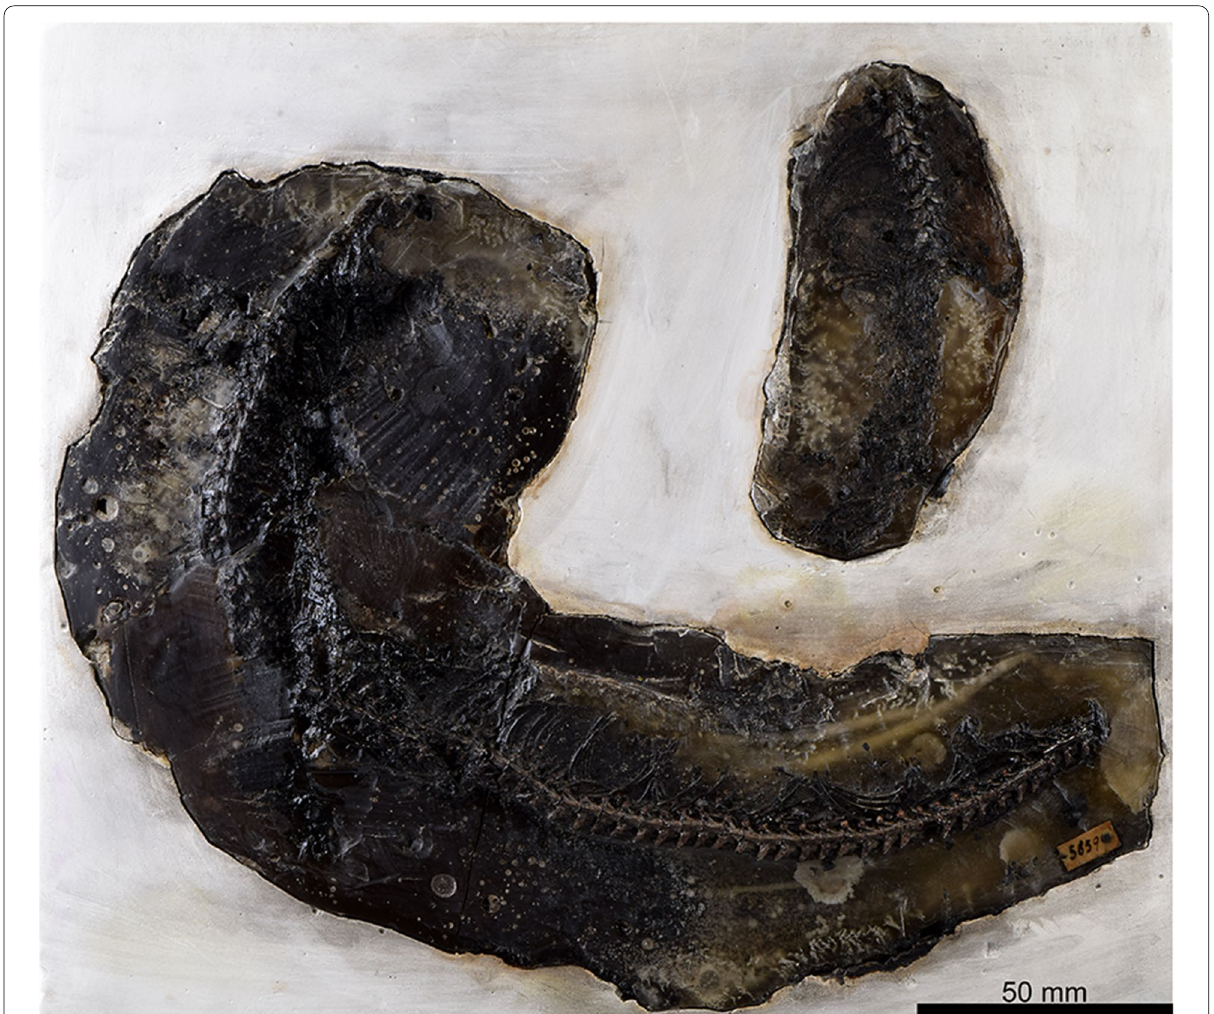
Fig. 107 Constrictores indet. from quarry Cecilie II, Geiseltal: several articulated trunk vertebrae on a matrix (GMH Ce II-5859-1930). Specimen originally figured by Kuhn (1939a:pl.